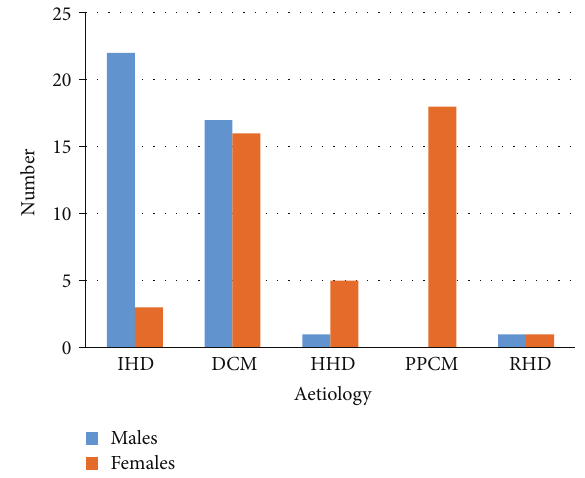
Figure 1: Distribution of aetiology of left ventricular thrombus by gender. IHD = ischaemic heart disease; DCM = dilated cardiomy- opathy; HHD = hypertensive heart disease; PPCM = peripartum cardiomyopathy; RHD = rheumatic heart